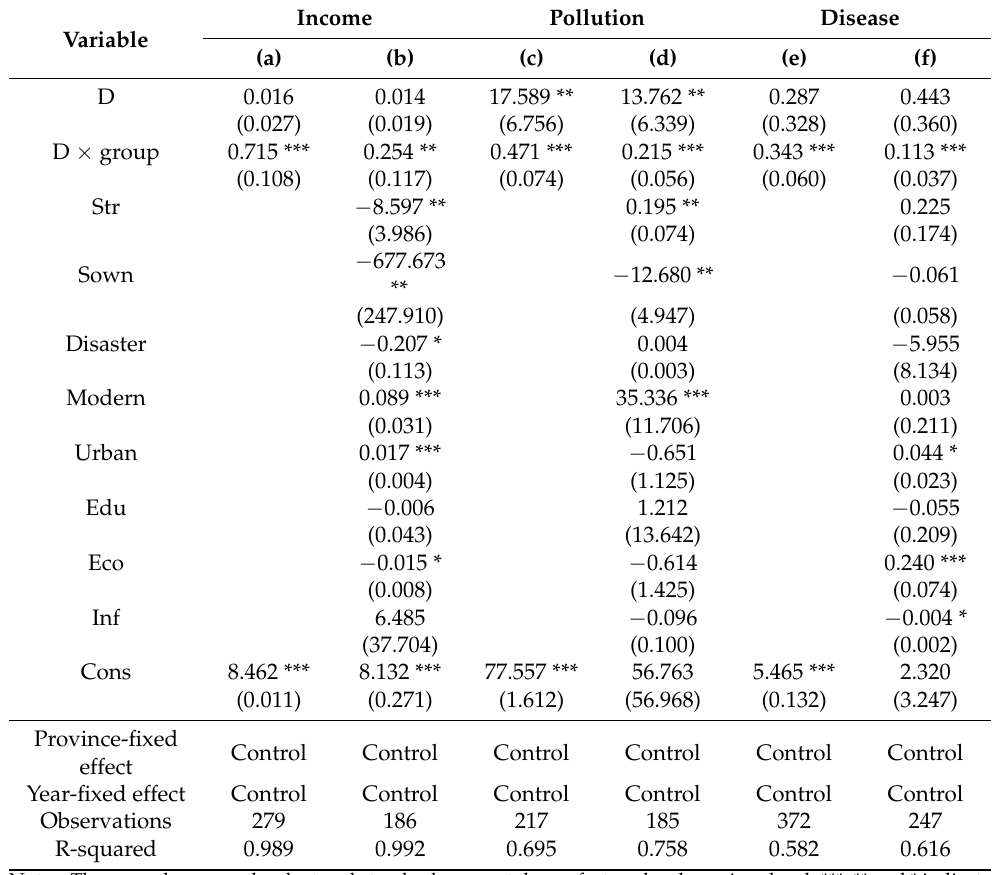
Table 8. Heterogeneity Analysis of